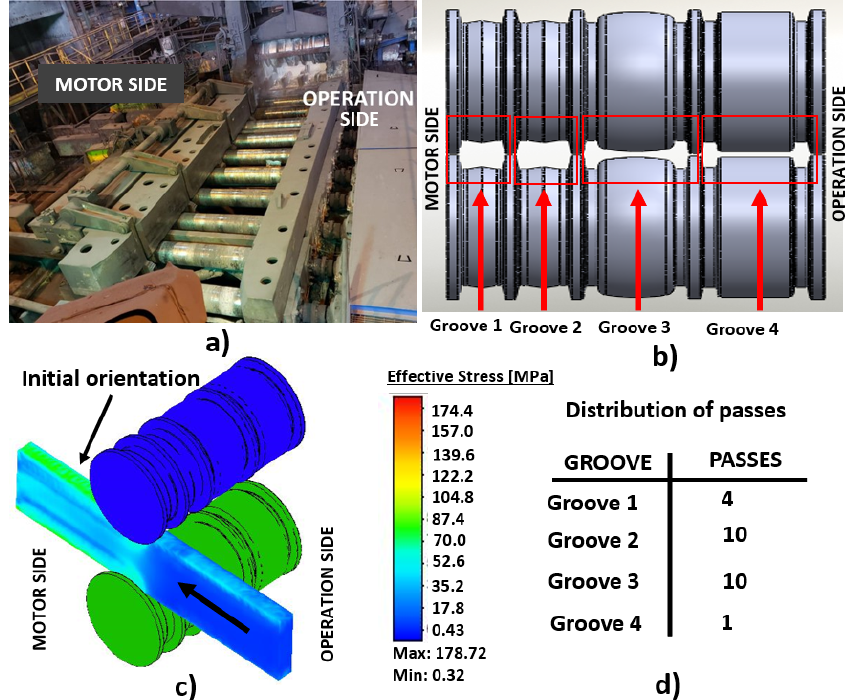
Figure 2. ( a ) Reversible hot mill; ( b ) location and geometry of each groove of the work roll; ( c ) initial orientation of the beam on the mill; ( d ) distribution of passes for each